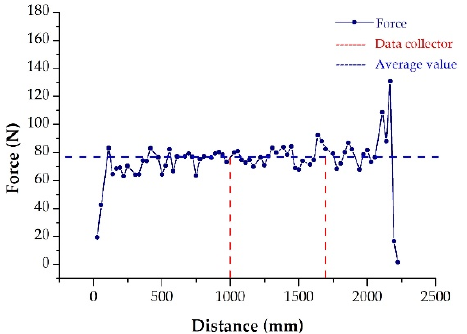
Figure 7. Determination of opening furrow force.